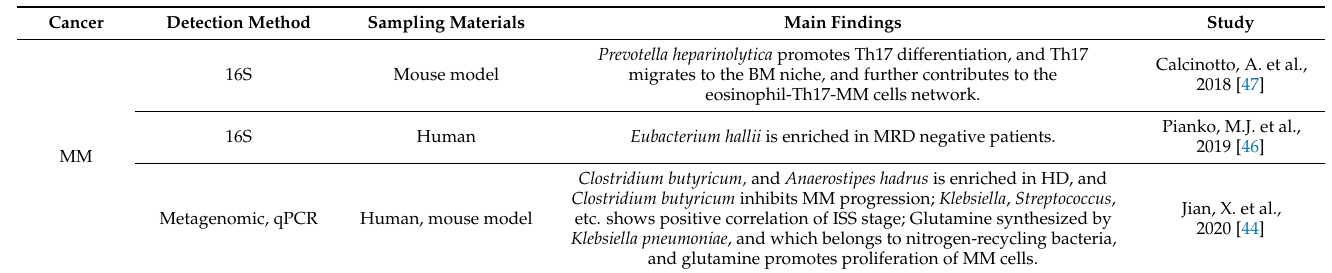
Table 3. Relationship between intestinal microbes and